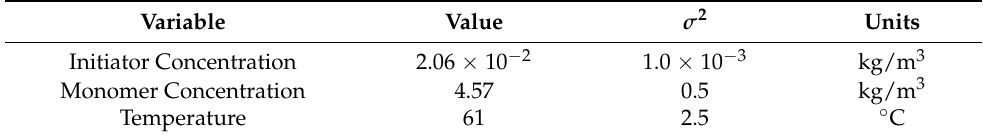
Table 1. Initial batch conditions for PMMA